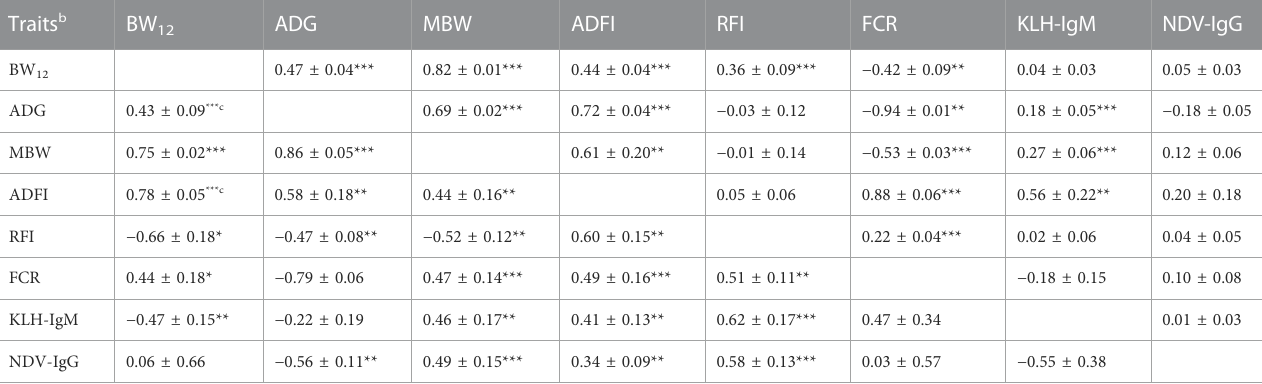
TABLE 3 Estimates of genetic a (lower diagonal) and phenotypic a (upper diagonal) correlations among production, feed ef fi ciency and immune traits measured during the growing period (9 – 20 weeks of age). Traits